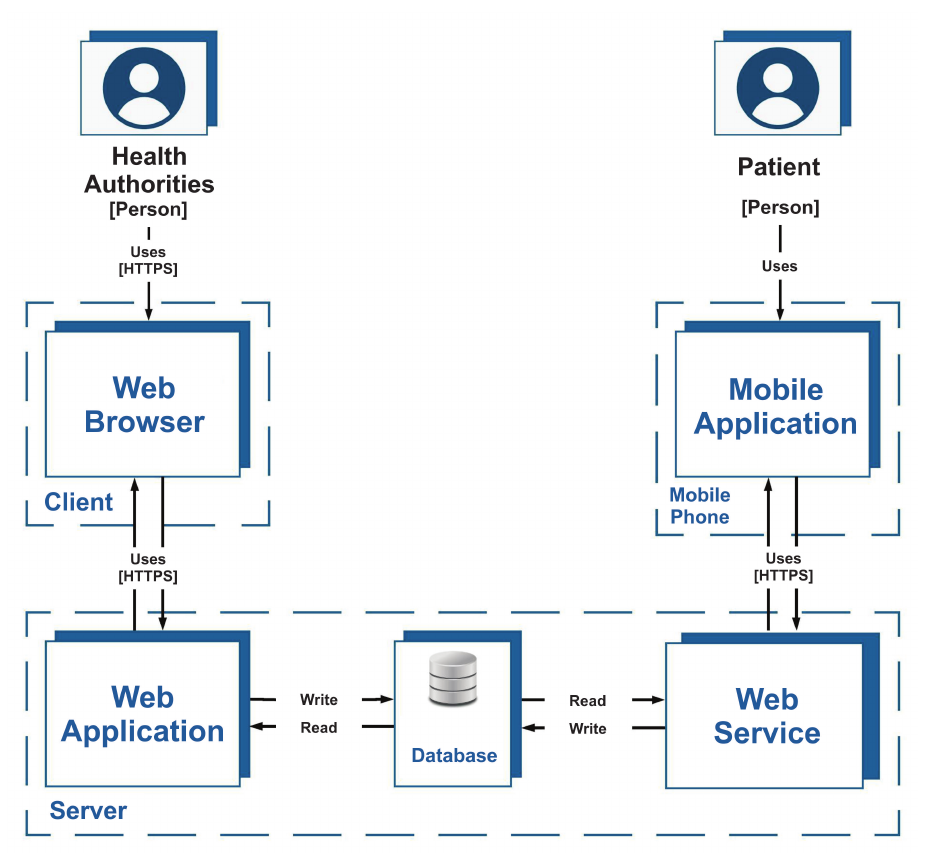
Figure 2. Static view of the platform. The deployment of the mobile app took place in the three main mobile app stores. Deployment of the web application was performed on the web server using